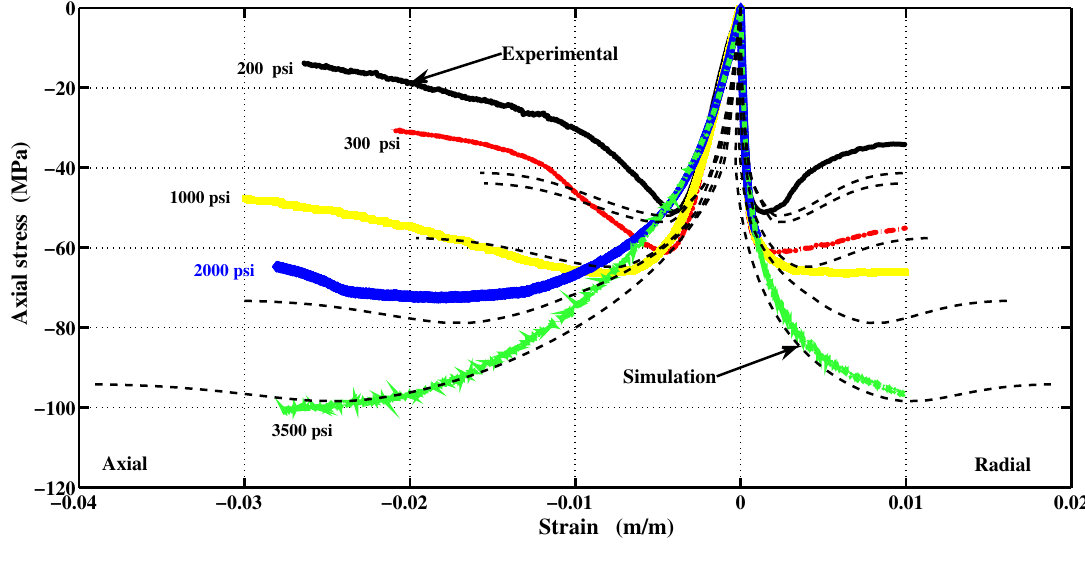
Figure 12. Comparison between numerical and experimental results for concrete under triaxial compression at different confinement